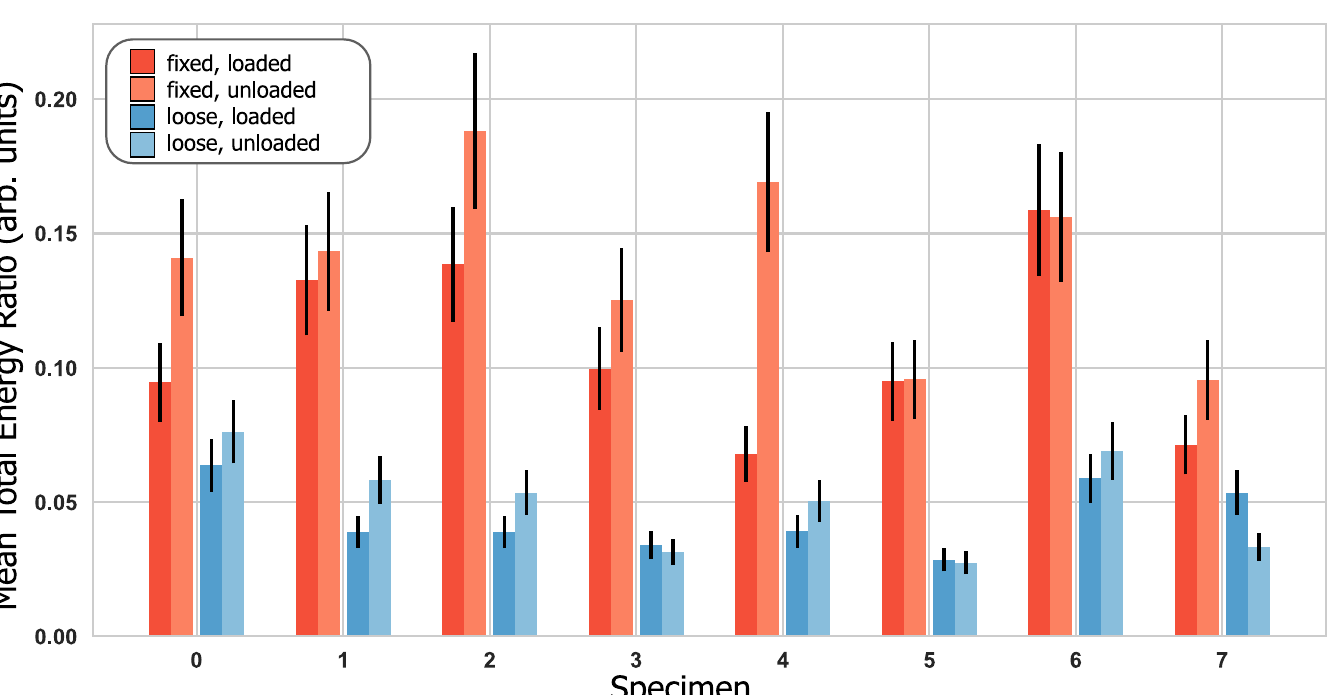
Fig 7. Mean total signal energy ratio between the bone sensor and the implant sensor with error bars depicting the estimated uncertainty. The ROC-AUC values were 1.0 (loaded) and 1.0 (unloaded).